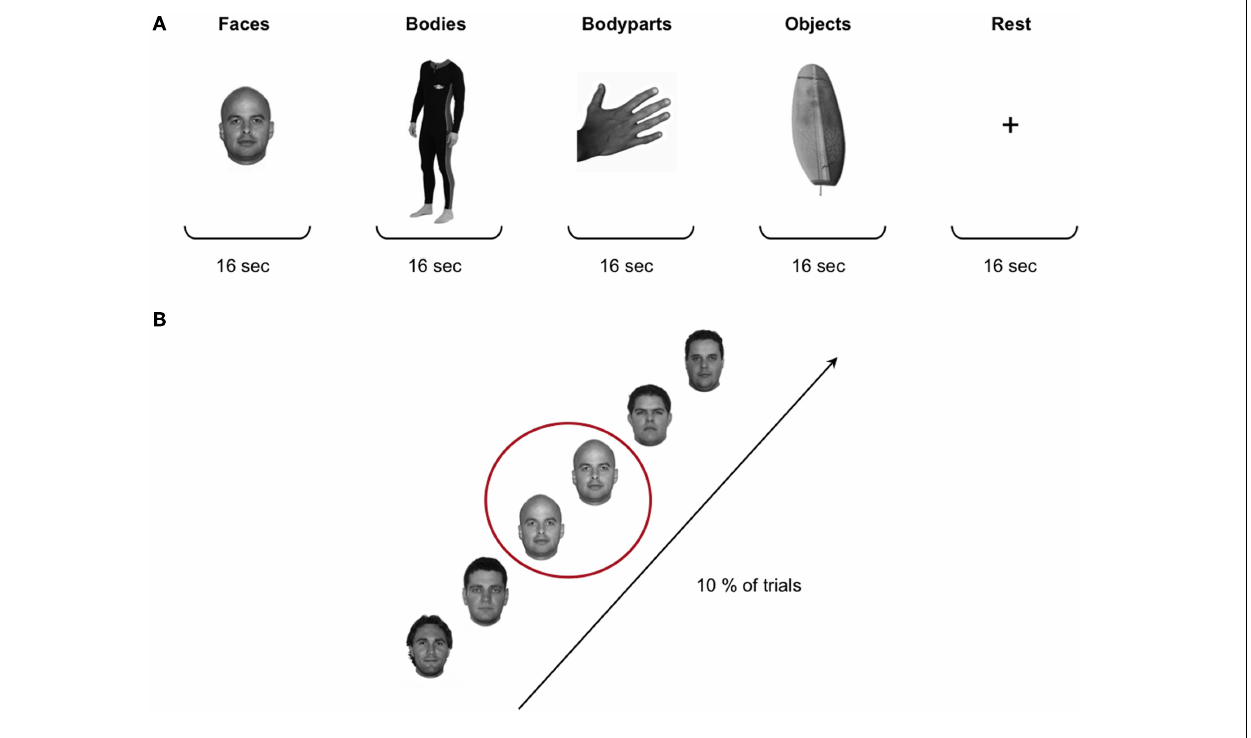
which a fixation cross was shown in the middle of the screen. (B) Participants performed a standard “one-back” task to ensure maintenance of attention to the stimuli, that is they were instructed to press a button whenever a particular image was repeated consecutively, which occurred on 10% of the